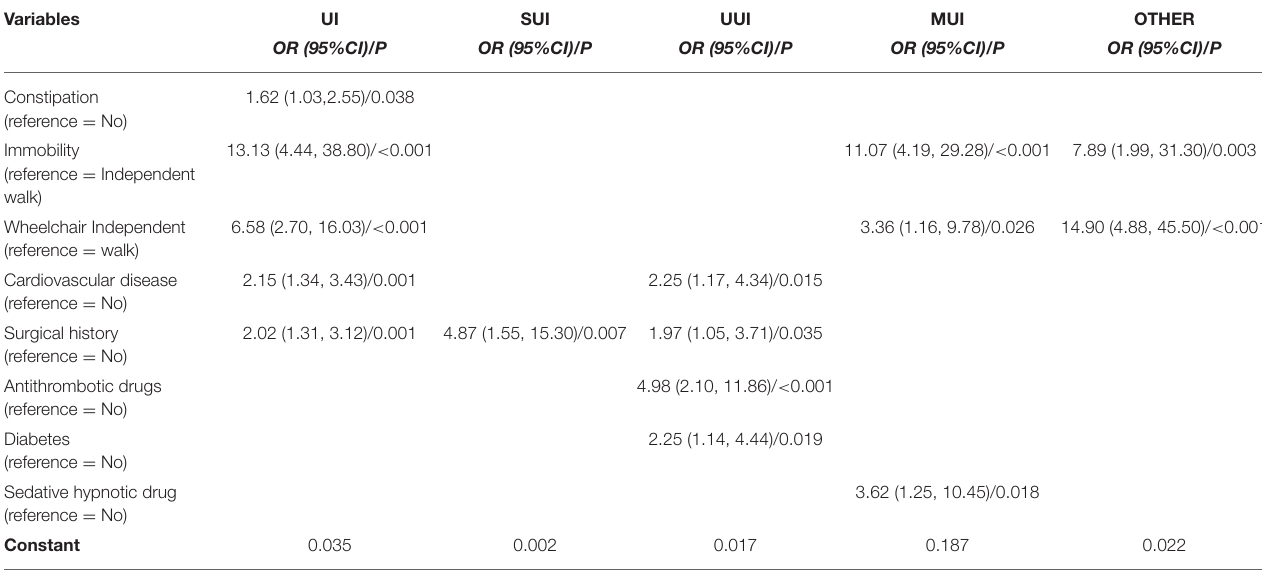
TABLE 4 | Multivariate logistic regression model with UI and subtypes in the geriatric population of nursing homes. Variables